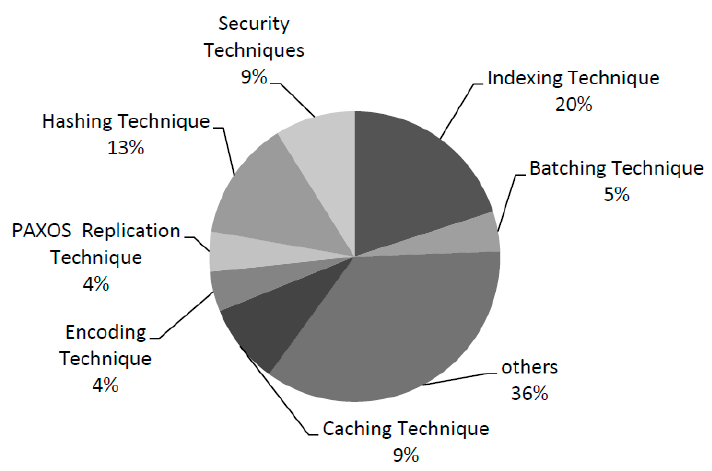
Figure 8. Techniques used in primary studies.